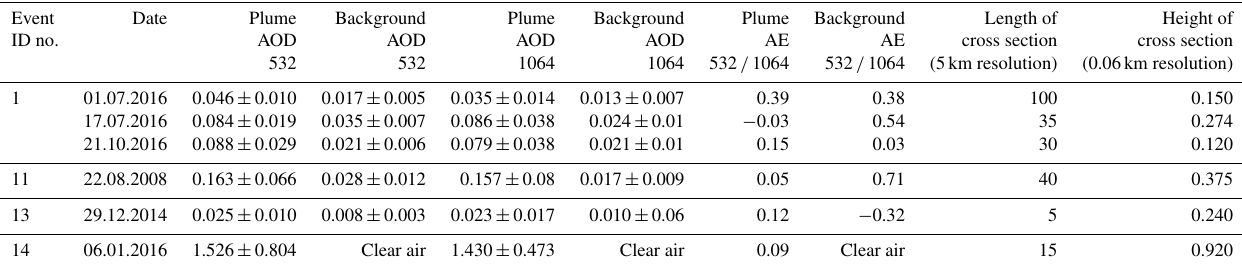
Table 7. Mean plume values of aerosol optical properties based on CALIPSO lidar